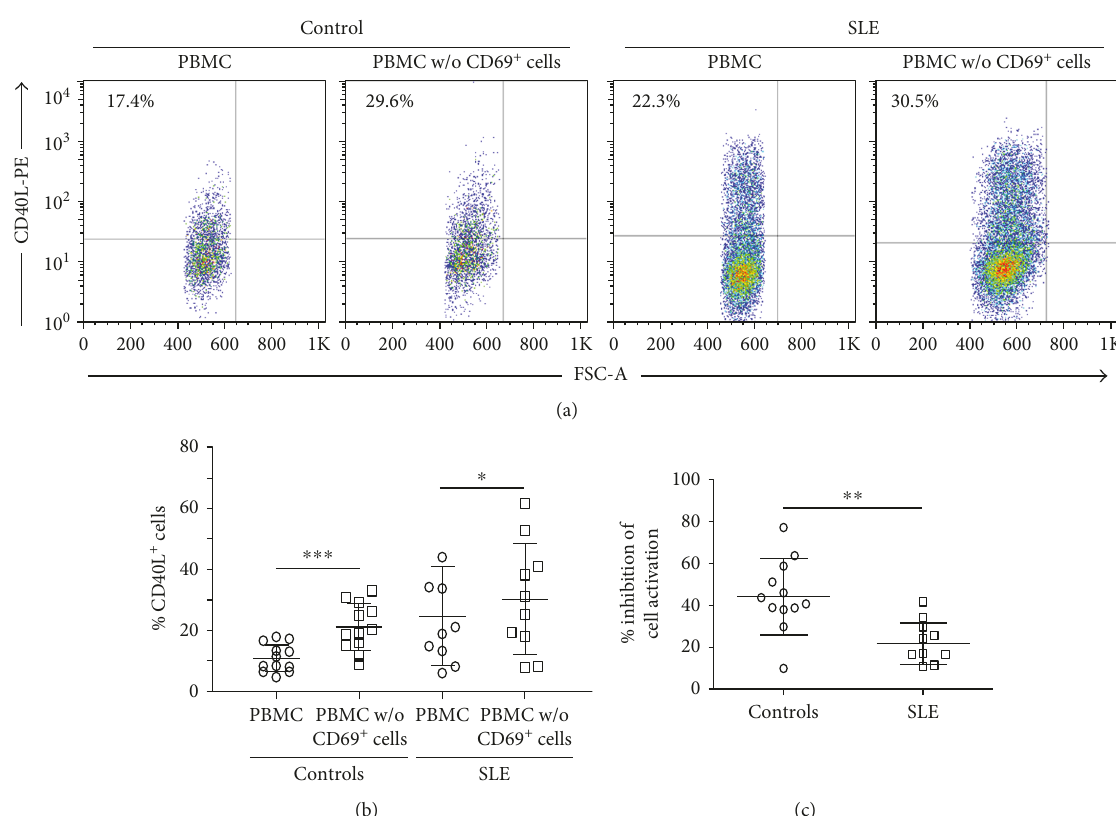
Figure 4: Suppressive function of CD69 + Treg lymphocytes in patients with SLE and healthy controls. Freshly isolated PBMC from 10 patients with SLE and 12 healthy individuals were depleted or not of CD69 + cells and then stimulated through CD3/CD28 for 7 hours. Finally, the expression of CD40L was assessed by fl ow cytometry. (a) Representative dot plots of CD40L expression in cell cultures of nondepleted (PBMC) or depleted (PBMC w/o CD69 + cells) from CD69 + cells in samples from a healthy control (left) and a SLE patient (right). (b) Levels of CD40L + cells in samples from healthy controls and SLE patients. (c) Percent of suppression of cell activation in samples from healthy controls and SLE patients. Data correspond to the arithmetic mean and SD. ∗ p < 0 05 , ∗∗ p < 0 01 , ∗∗∗ p < 0 005